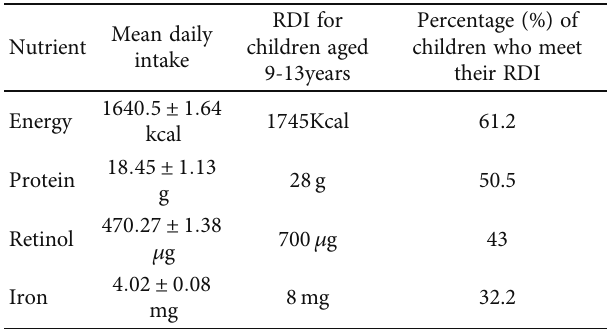
Table 5: The nutrient intake of the children according to the 24- hour